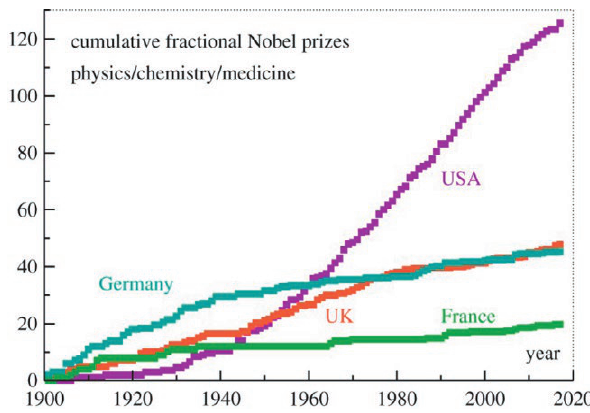
Figure 1. The cumulative number of physics, chemistry and medi- cine Nobel prizes per country. Prizes are attributed to the respective country according to the nationality of the recipients at the time of the announcement, with prizes obtained by more than one recipient accordingly divided. Note that the US population increased from 76 to 327 million during 1901–2017.